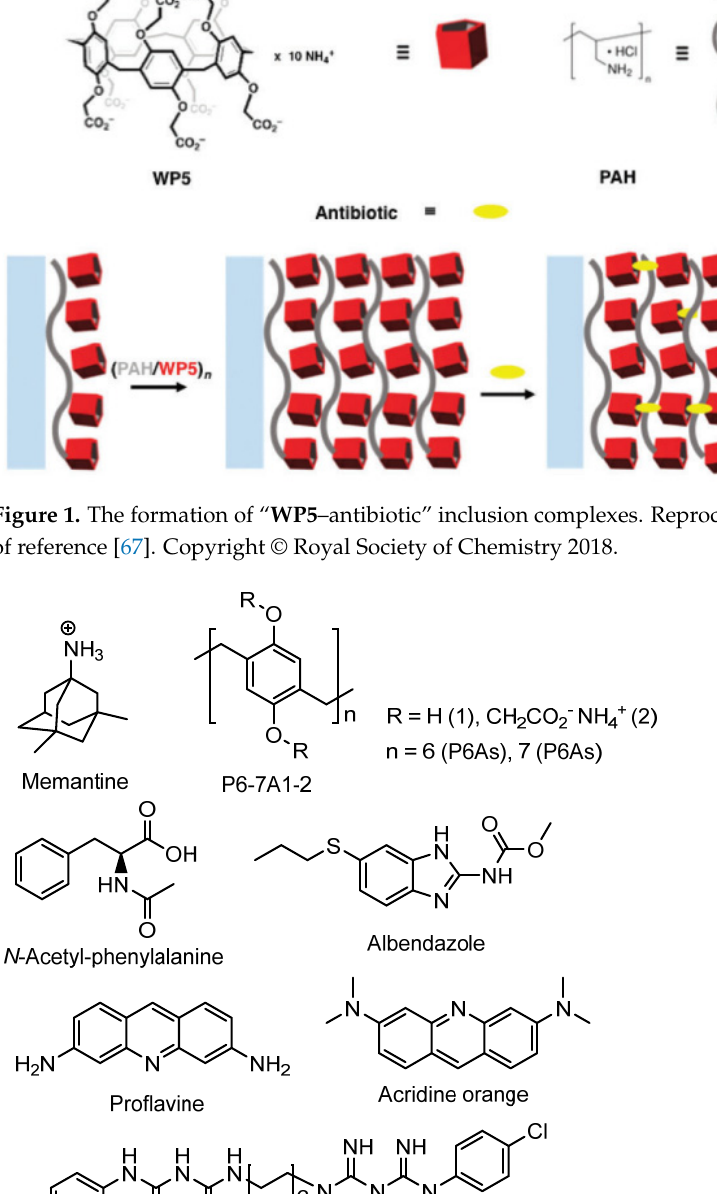
Figure 2. P6A - and P7A -based hosts and small molecules-based guests.